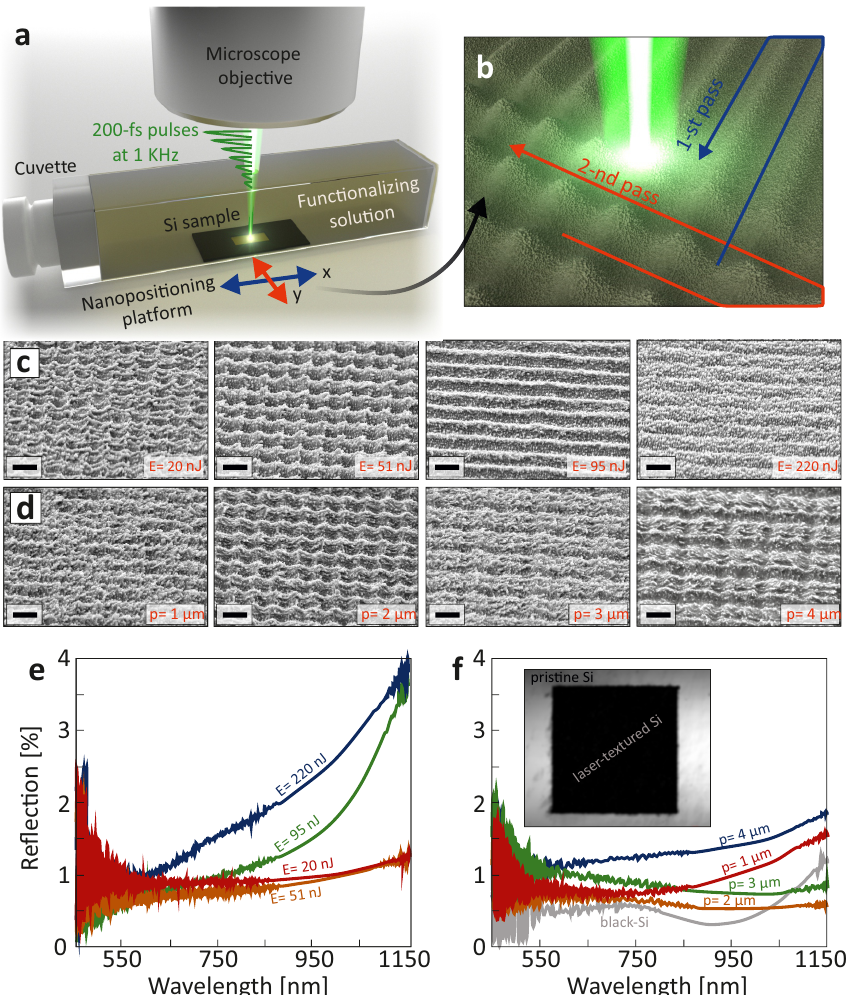
Figure 1. Fabrication of chemically functionalized ultra-black Si surface. ( a ) Artistic representation of the setup for liquid-assisted fs-laser texturing and functionalization of Si surface. ( b ) Illustration of the double-pass scanning scheme to process the Si surface with the laser beam. ( c , d ) A series of side-view (view angle of 45 ◦ ) SEM images of the Si surface processed at varied pulse energies E and lateral intervals between scanning lines p : ( c ) E increases from 20 to 220 nJ at p = 2 µ m; ( d ) p increases from 1 to 4 µ m at fixed E = 51 nJ. Fixed κ = 1 KHz and ν = 0.5 mm/s were used. Scale bar indicates 2 µ m. ( e , f ) FTIR reflection spectra measured from corresponding nanotextured surfaces shown in panels ( c , d ). Inset image in ( f ) shows the bright-field optical image of the square-shaped (200 × 200 µ m 2 ) laser-textured Si